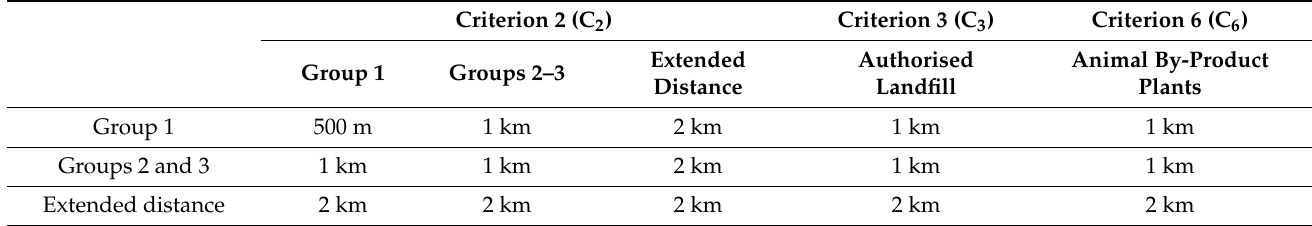
Table 3. Distances considered for criteria C 2 , C 3 , and C 6